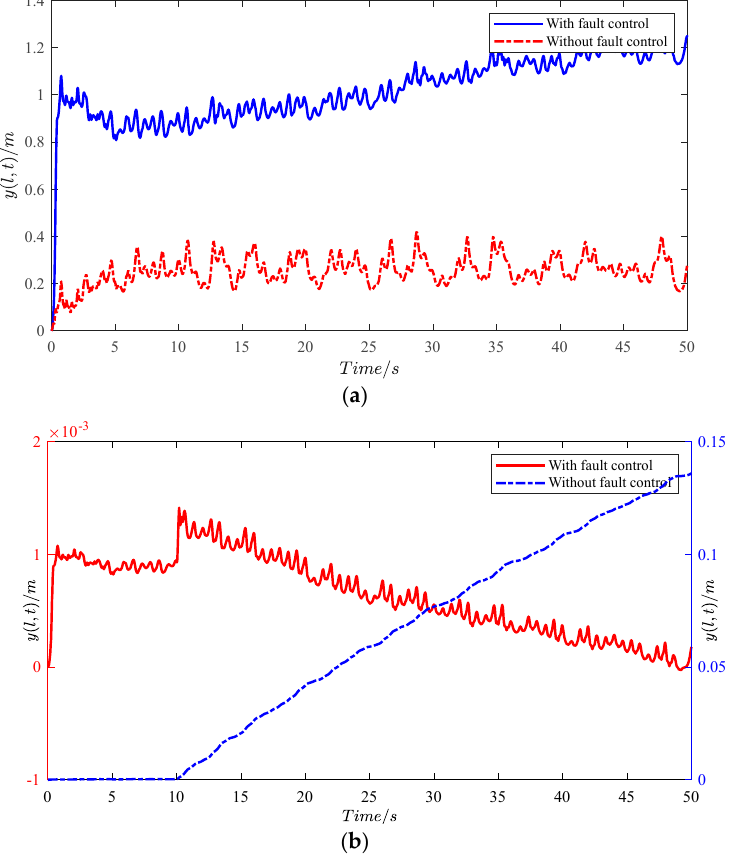
Figure 6. The control effect of fault control. ( a ) With actuator fault; ( b ) without actuator fault.